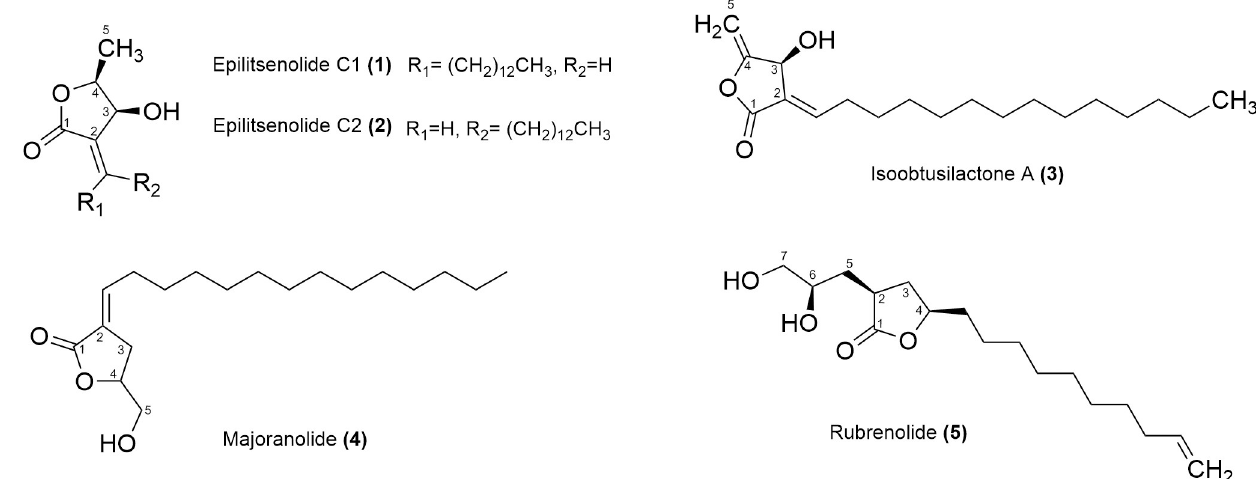
Fig 1. Chemical structures of the butanolides isolated from Aiouea trinervis (1–3) and Mezilaurus crassiramea (4 and 5).